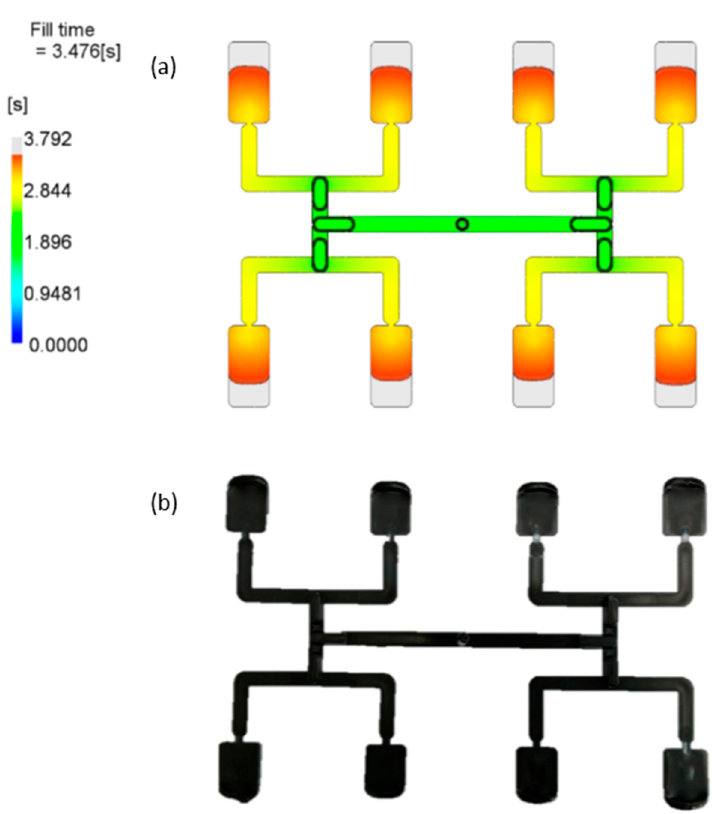
Figure 6. Results of simulation and experimentation for the optimum set of data (by Response Surface Methodology (RSM)): ( a ) simulation, ( b ) experiment.